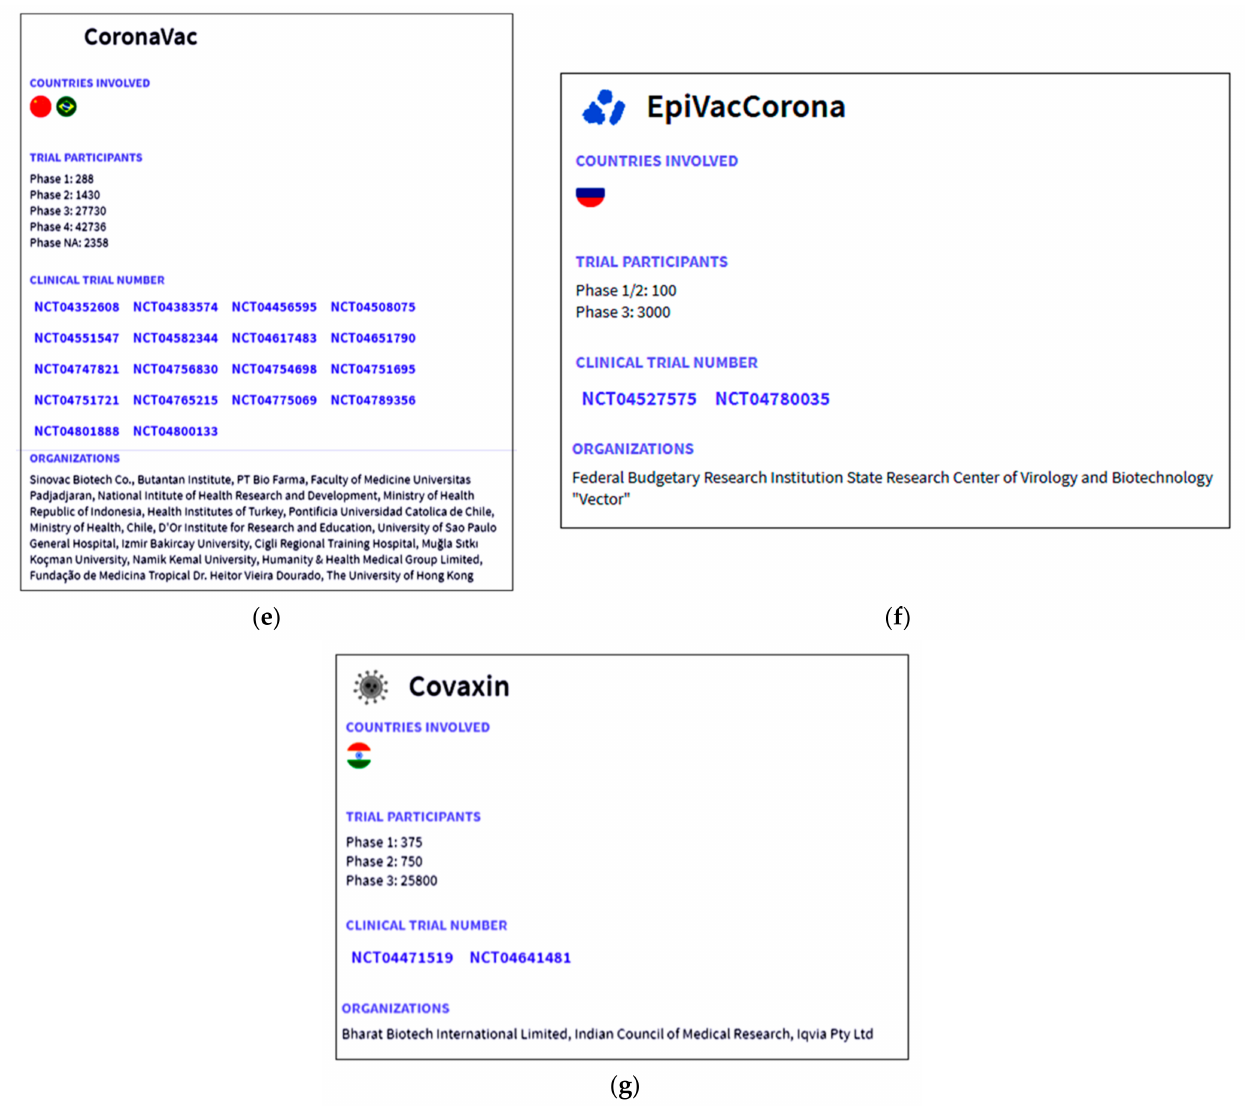
Figure 4. Information about the clinical trials of Asian-origin COVID-19 vaccines such as country involved, trial patients, clinical trial number, and organization involved for a clinical trial or any vaccine development. ( a ) Ad5-nCoV, ( b ) BBIBP-CorV, ( c ) Sputnik V, ( d ) ZF2001, ( e ) CoronaVac, ( f ) EpiVacCorona, and ( g ) Covaxin. (Data source: